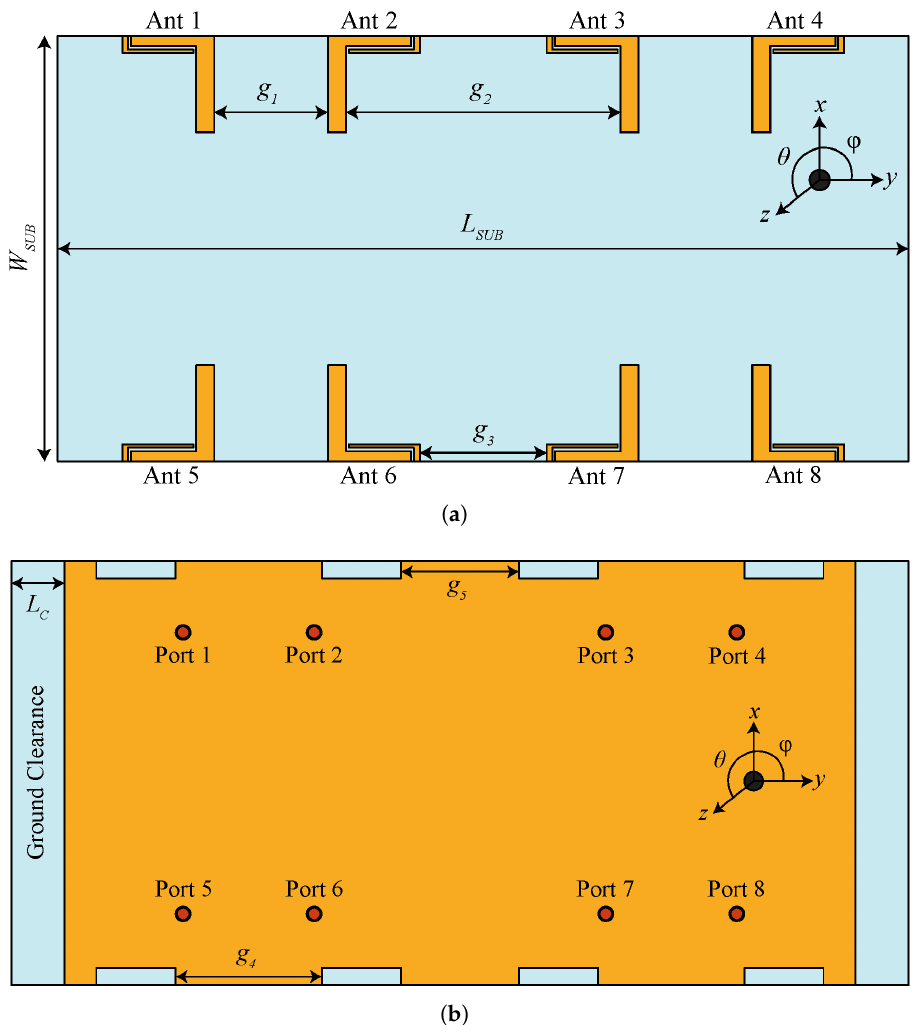
Figure 6. The proposed MIMO antenna system (a) front-view and (b) back-view. antenna element equals 16.95 17 mm 2 , while the four elements occupy a space of about ×